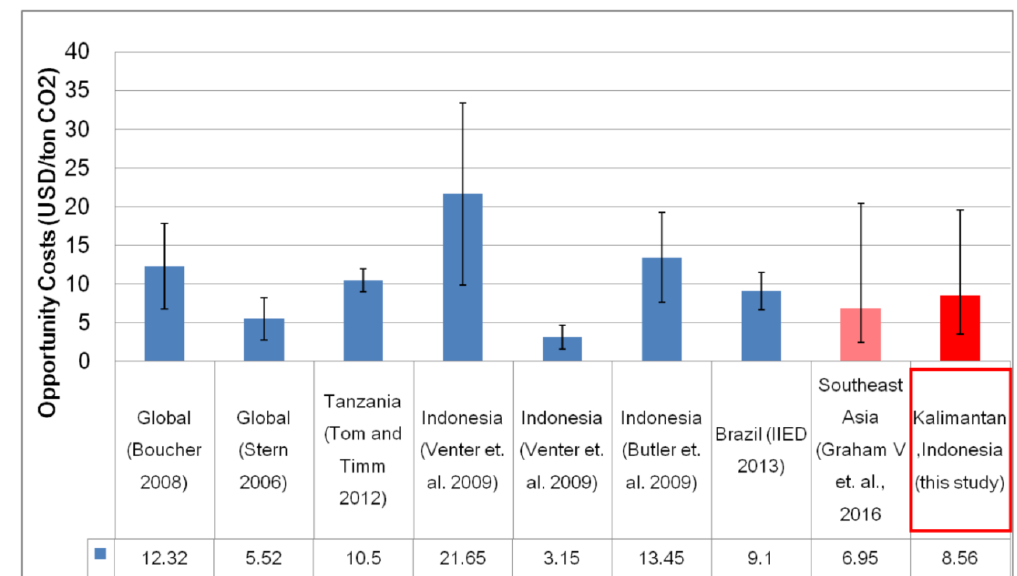
Figure 4. Opportunity costs (OC) from different sources.